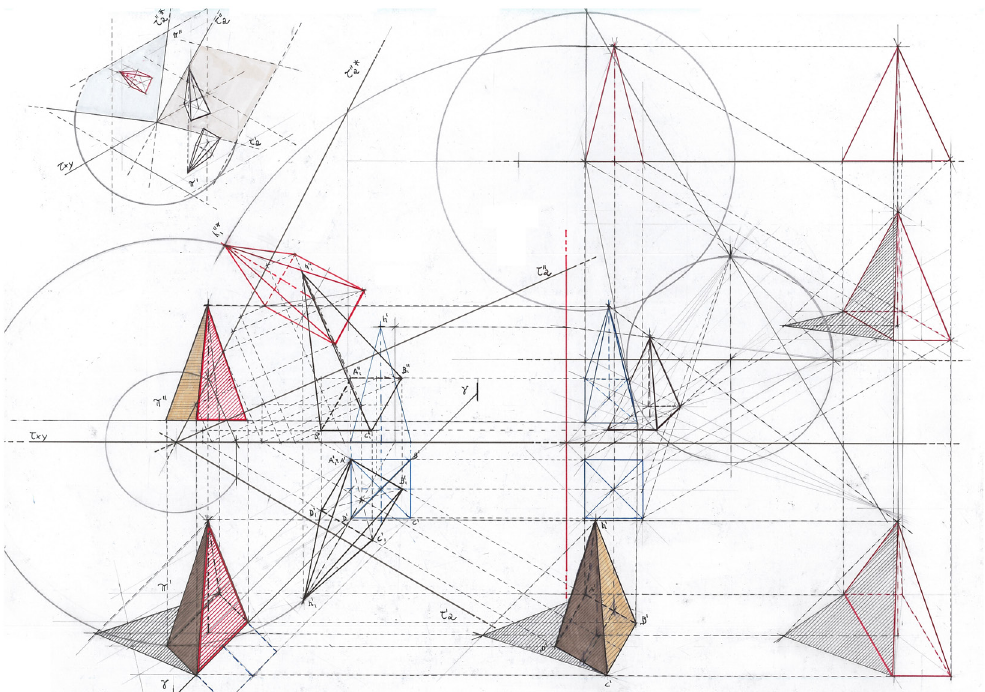
Fig. 4 Andrea Donelli, Morphological modeling inherent to homological and co-homological relations in the representation of lapis, on cardboard, 29.7x49.0